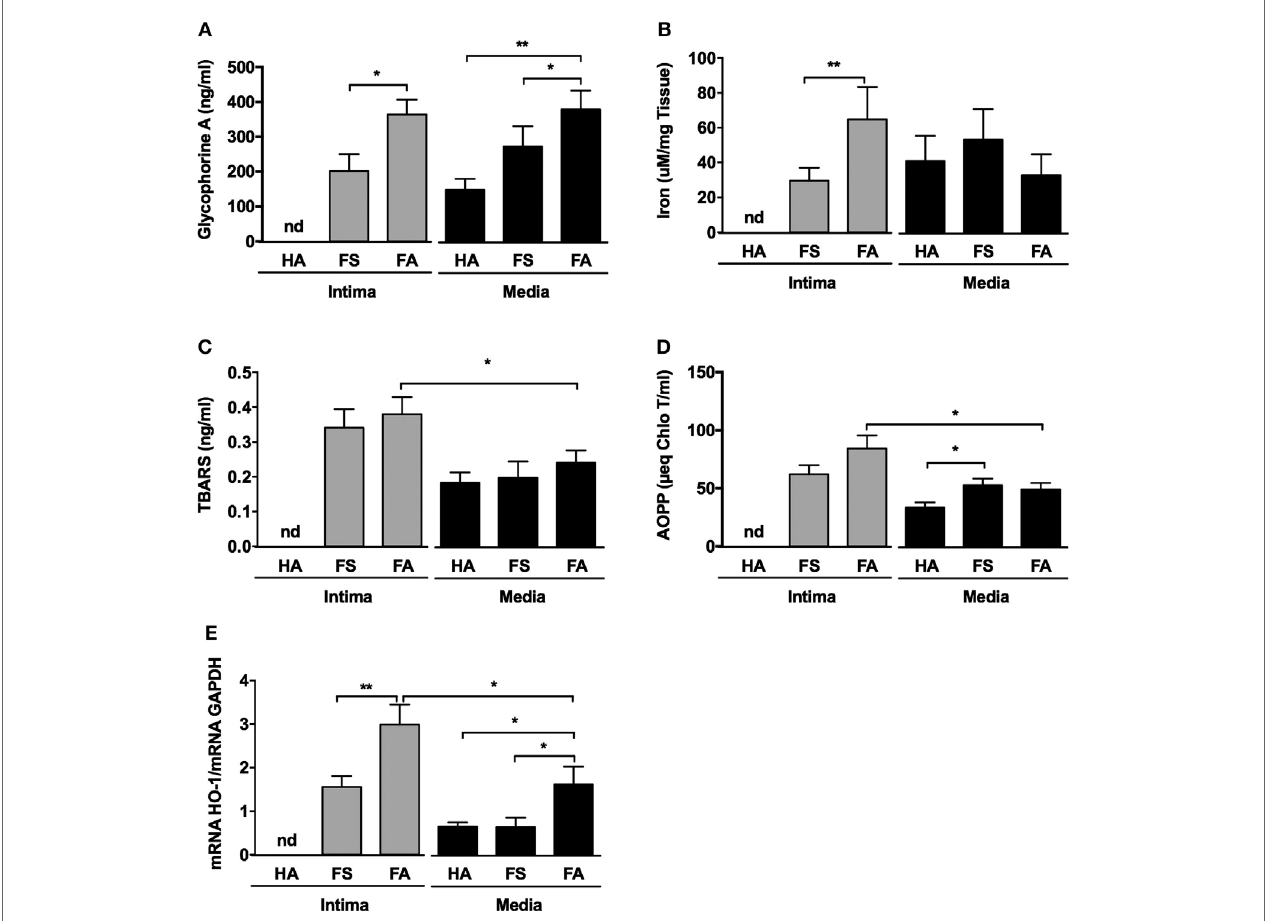
FigUre 4 | Fatty streaks (FSs) and fibroatheromas (FAs) display high glycophorin A concentration, increased iron content, and augmented oxidative stress. (a) Glycophorin A concentration ( n = 10) was determined in the conditioned media of healthy aortas (HAs), FSs, and FAs. (B) Iron content was evaluated in the corresponding tissues. (c,D) Thiobarbituric acid reactive substance (TBARS) [ n = 10, lipids, panel (c) ] and advanced oxidation protein product (AOPP) [ n = 10, proteins, panel (D) ] concentrations were determined in the same conditioned media described above. (e) The expression of Heme-Oxygenase-1 (HO-1) was evaluated in the intima and the tunica medias of healthy aortas (HA, n = 10) and from the tunica intimas ( n = 10) and tunica medias ( n = 10) of fatty streaks (FSs) and fibroatheromas (FAs). * p < 0.05, ** p < 0.01; Mann–Whitney’s